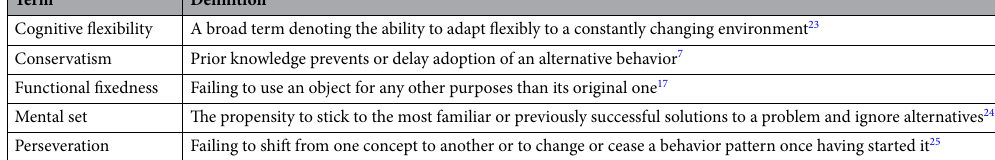
Table 1. Common terms used in analysis of behavioral